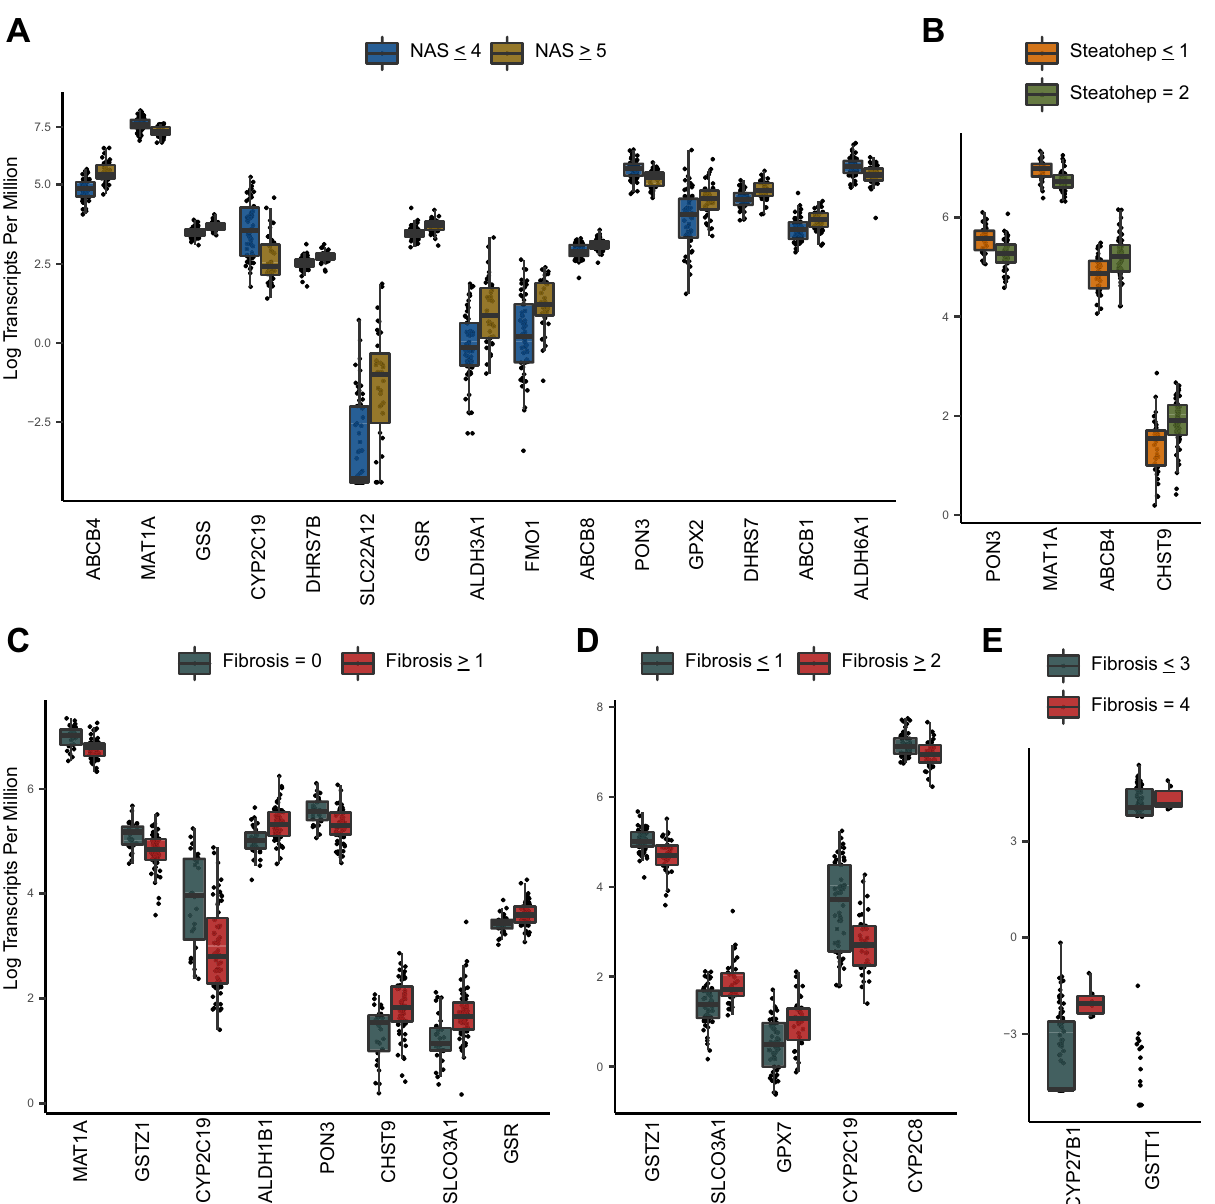
version 3.3.6. A Expression differences in pharmacogenes between NAS groups ( n =93). B Expression differences in pharmacogenes between steatohepatitis groups ( n =89). C – E Expression differences in pharmacogenes between fi brosis groups ( n =87). Source data are provided in the supplemental